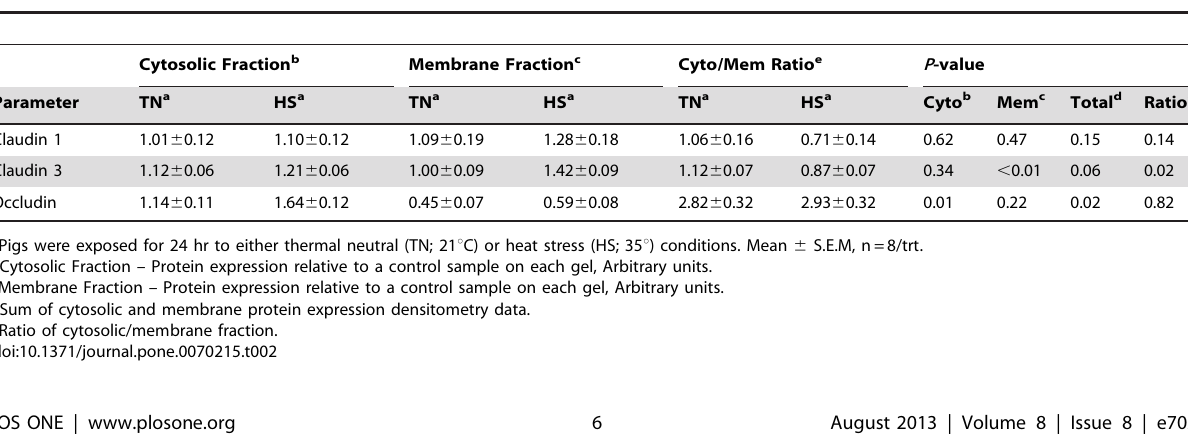
Table 2. Ileum tight junction protein expression from pigs reared in thermal neutral or heat stress conditions for 24